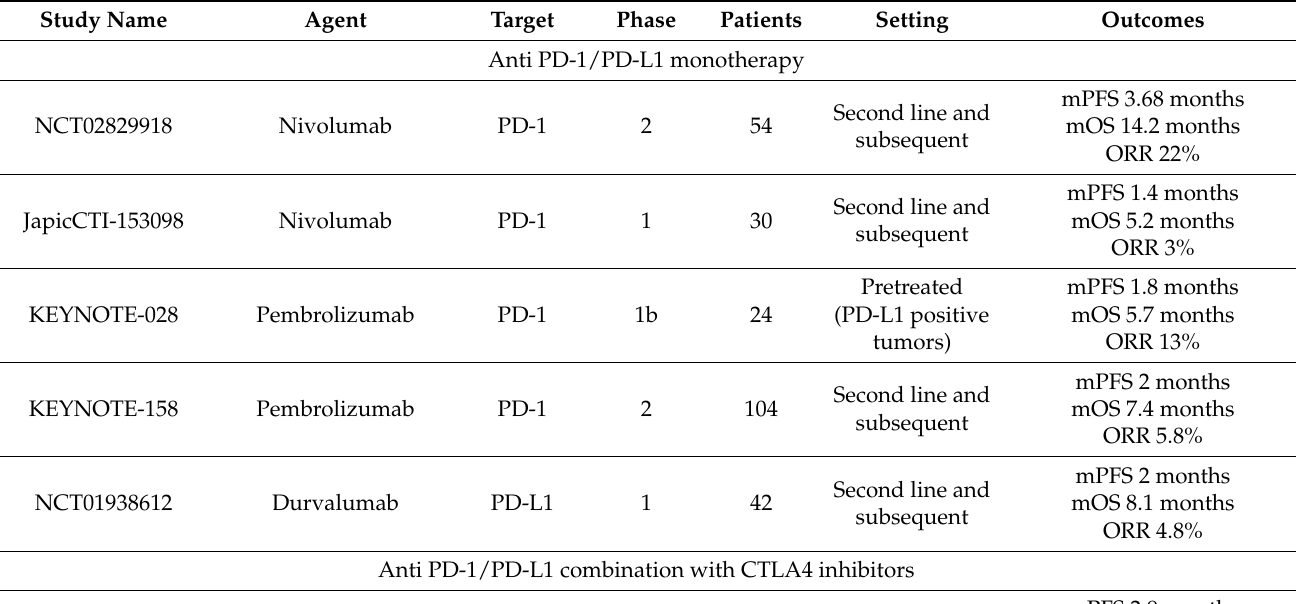
Table 1. Completed clinical trials assessing the use of immune checkpoint inhibitors (ICIs) for the treatment of biliary tract